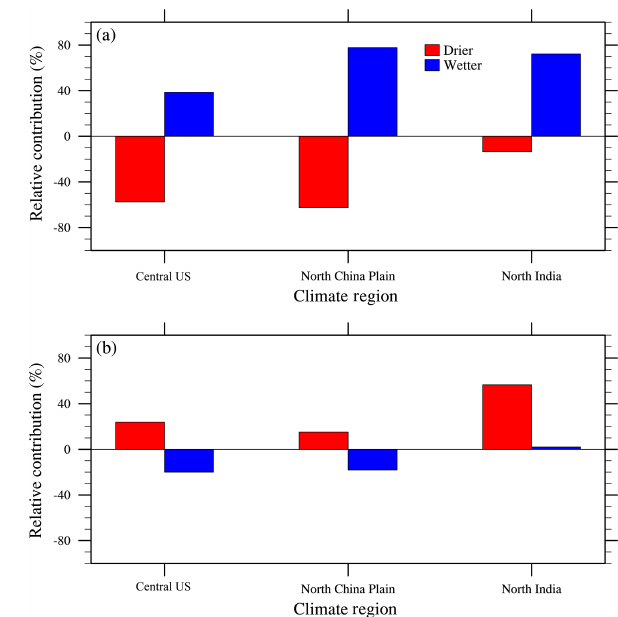
Figure 9. The relative contribution of GW extraction to regional (a) surface and (b) deep soil moisture trends (%). North China Plain (34–40 ◦ N, 110–120 ◦ E), northern India (23–33 ◦ N, 68–78 ◦ E), the central US (33–42 ◦ N, 97–105 ◦